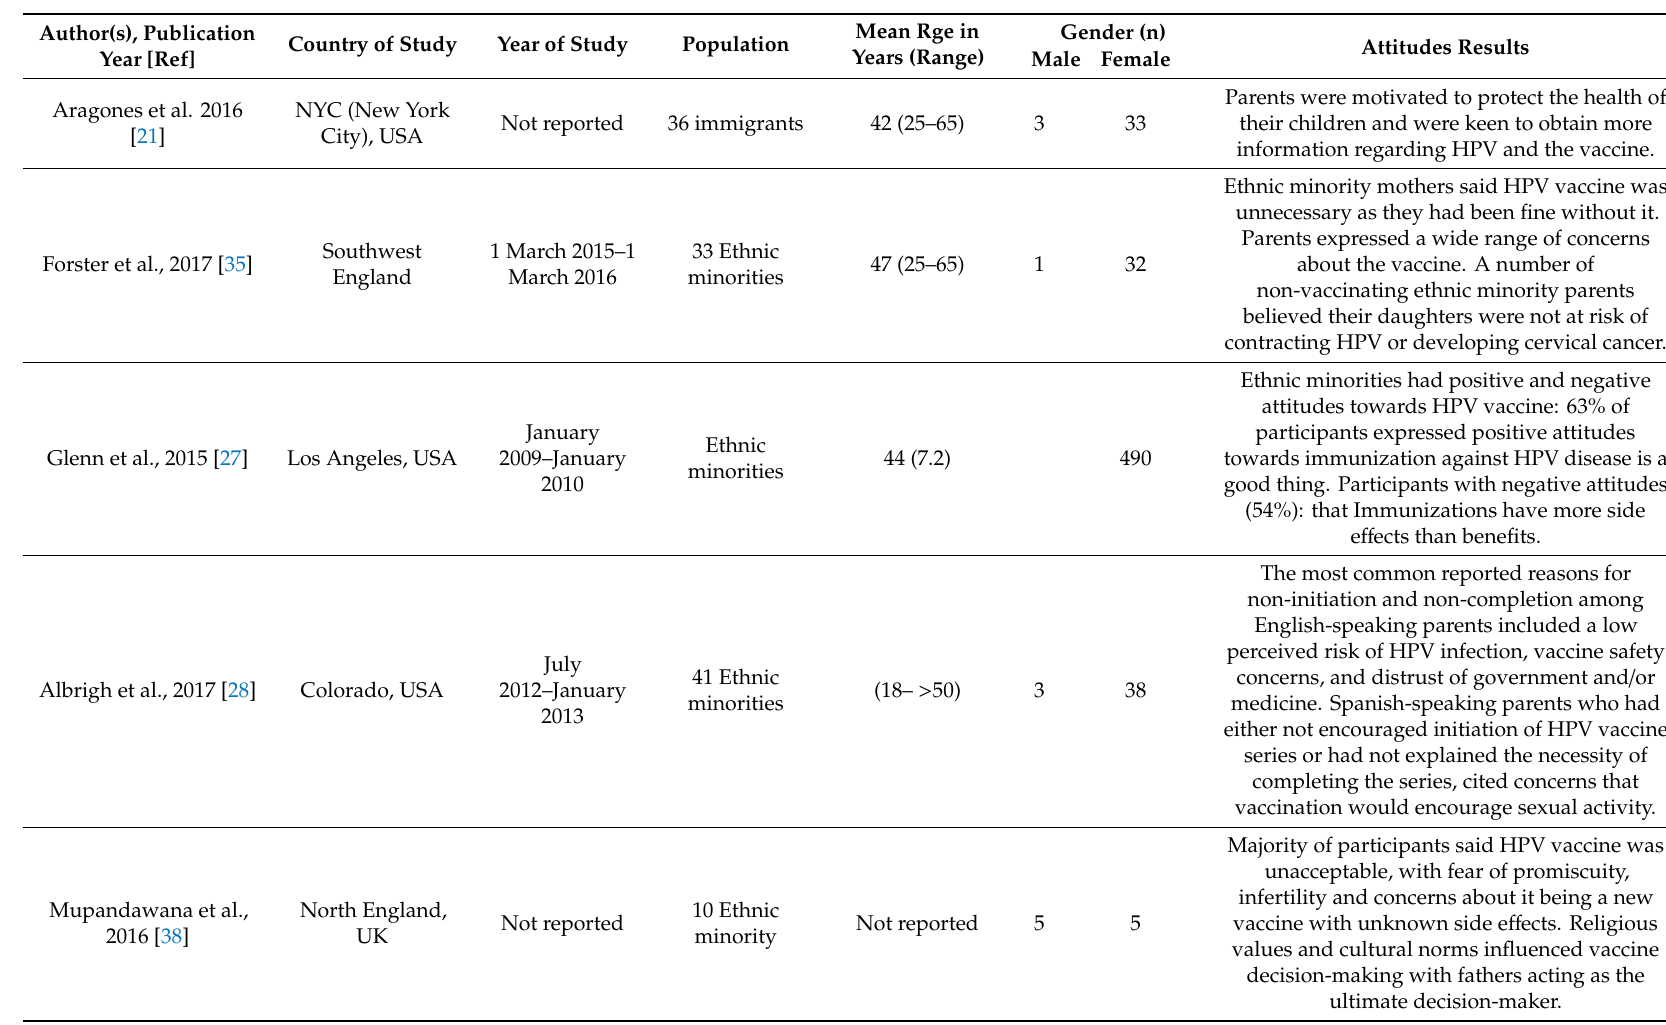
Table 3. Studies reporting attitudes of immigrants about HPV vaccine (13